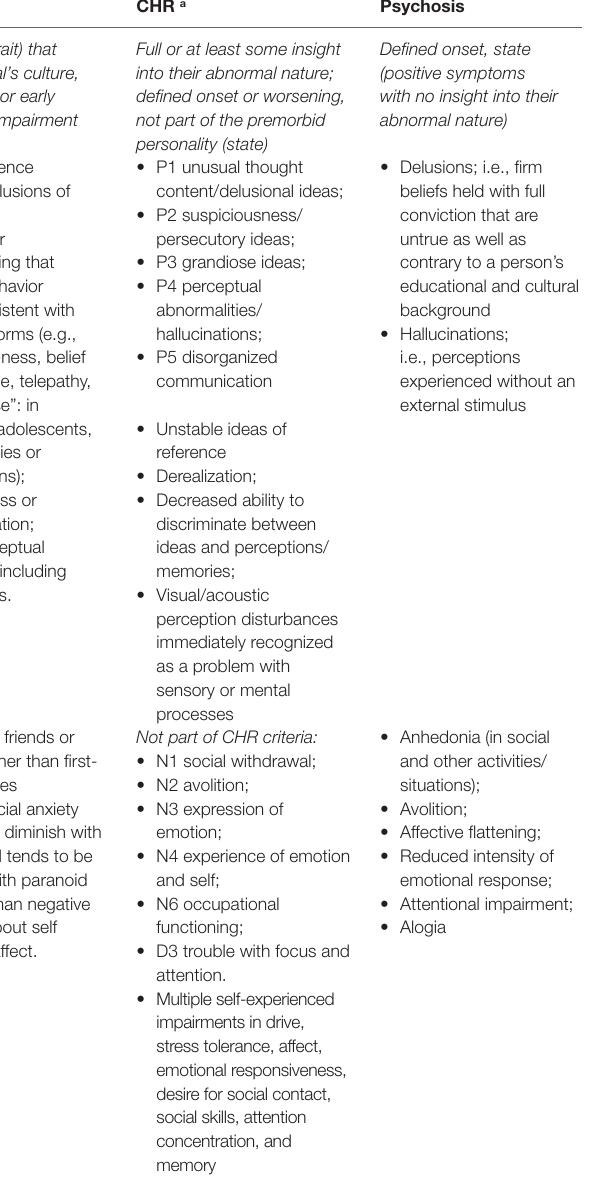
TABLE 1 | Current operationalizations of schizotypy, schizotypal disorder according to ICD-10, SPD and other schizophrenia-spectrum PD according to DSM-5, clinical high risk (CHR) of psychosis and psychosis (15,